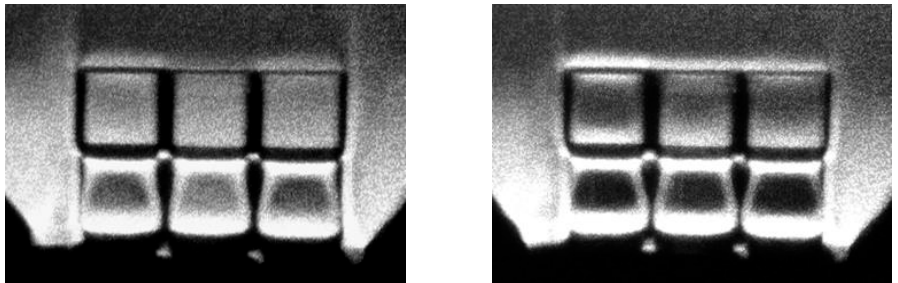
Figure 13. Schlieren images recorded during heating of the 40 × 40 mm